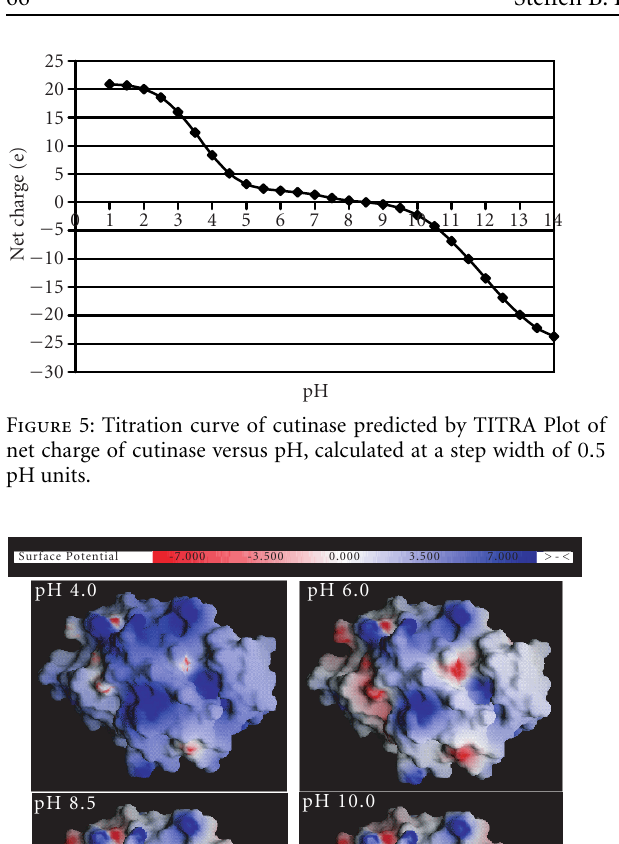
a capability of refolding at temperatures below T m (Figure 2).